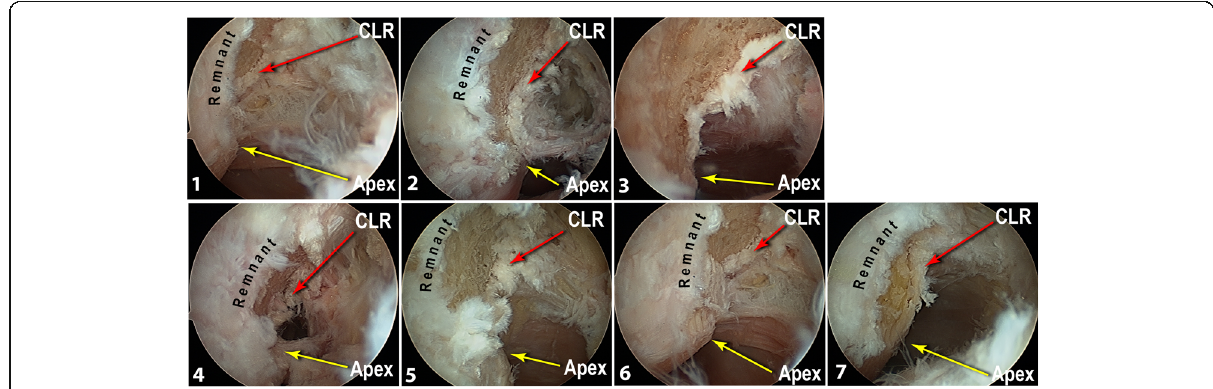
Fig. 2 Arthroscopic views of the right knees (through anterolateral portal) medial part of the lateral femoral condyle for the seven specimens after debridement. For each one, Capsular Line Reference (red arrow), apex of the posterior cartilage (yellow arrow) and remnant fibers of the ACL are